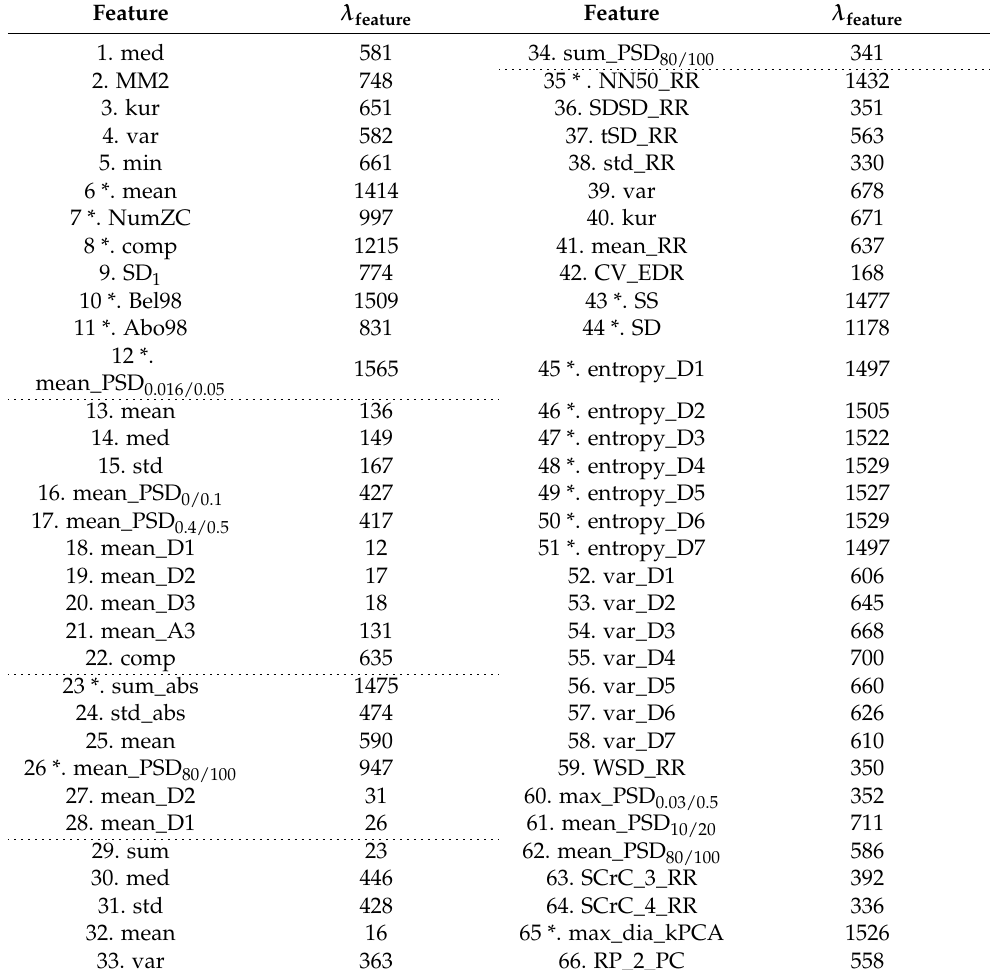
Table 1. Feature selection results in the experiment with event duration using statistical analysis (Features 1–12 from the SaO 2 signals, features 13–22 from the airflow signals, features 23–28 from the abdominal signals, features 29–34 from the thoracic signals, and features 35–66 from the ECG signals; four dashed lines divide the table into five parts according to the kind of signals); * denotes selected best feature